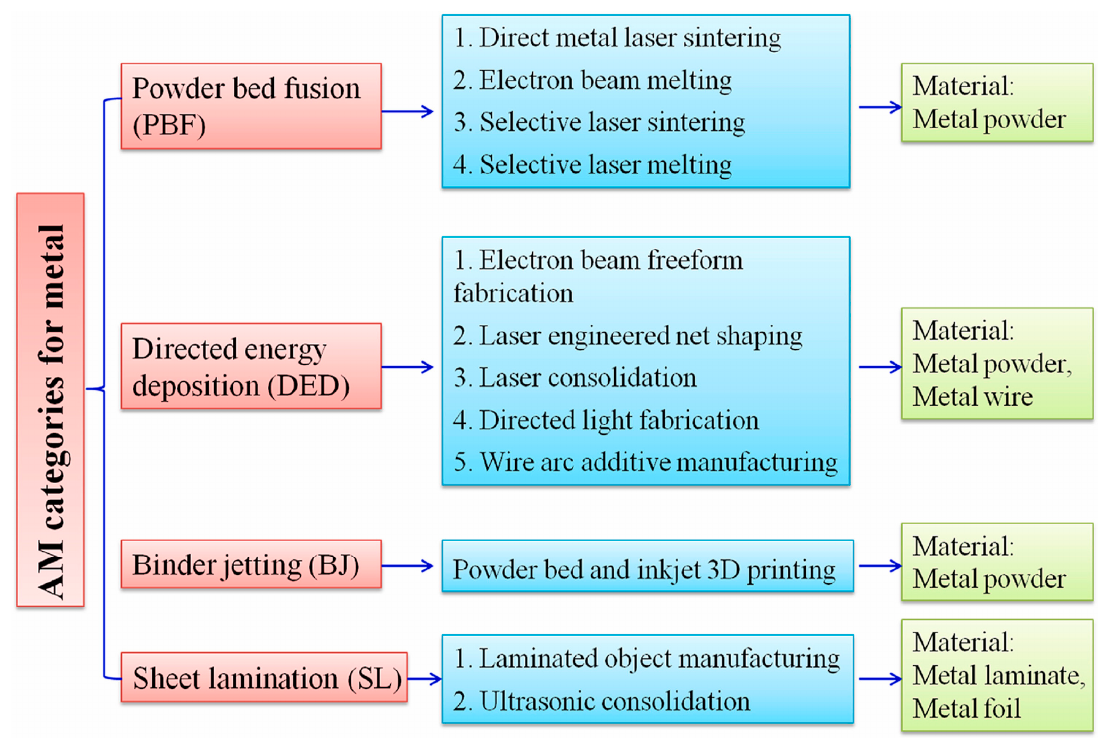
Figure 1. Classification of metal additive manufacturing, reproduced or adapted from [13], with permission from Elsevier, 2021.